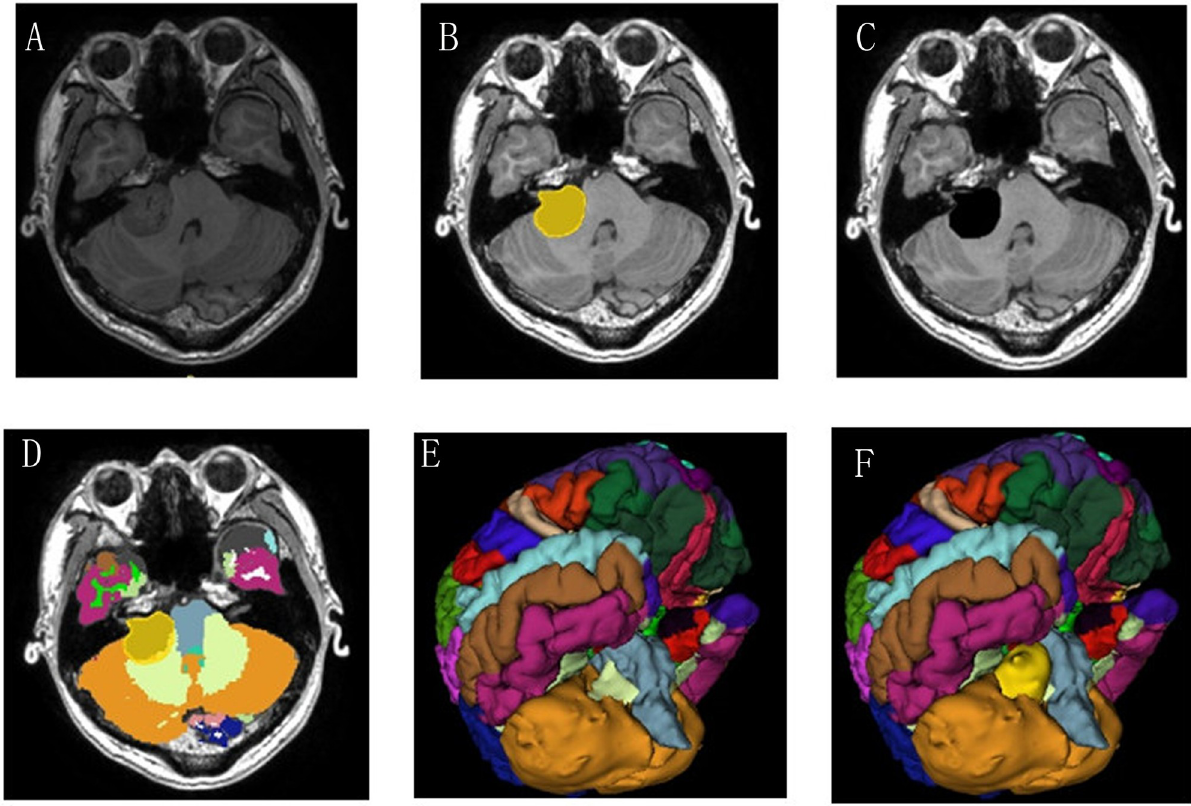
Fig 3. (Sub 8, Right Acoustic neuroma). These images depict the segmentation results in an axial (A-C) slice for manual tumor segmentation in 3D Slicer and automatic segmentation of brain structures without the tumor in FreeSurfer. The brainstem and cerebellum were pushed by the tumor